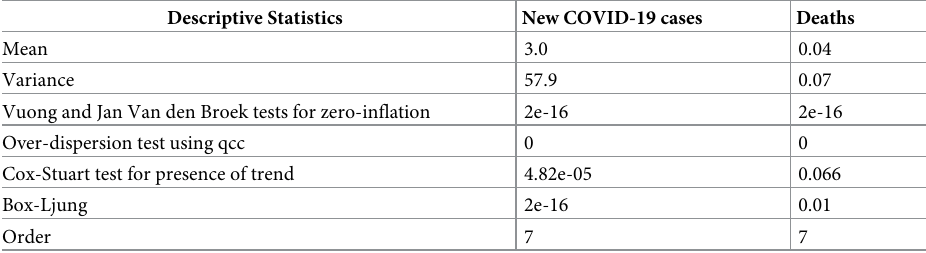
Table 1. Descriptive statistics and test results for COVID-19 active cases and deaths series in Mauritius.